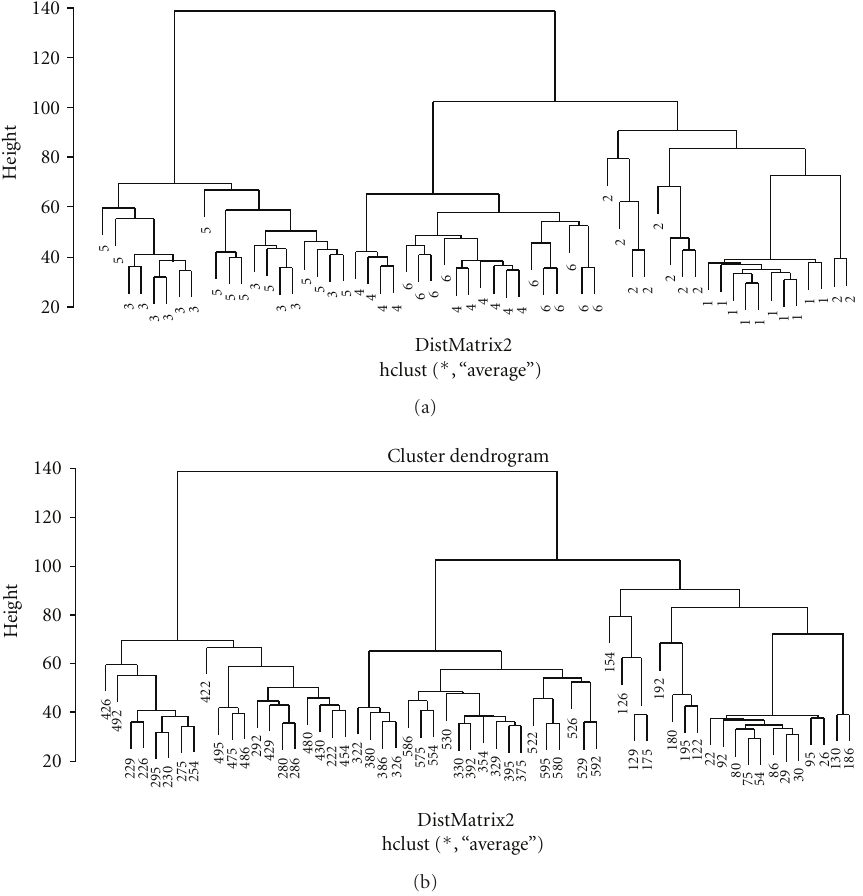
Figure 7: (a) Six characteristic groups at the dendrogram by using Euclidean similarity function. (b) The corresponding row numbers of the dataset at the dendrogram by using Euclidean similarity